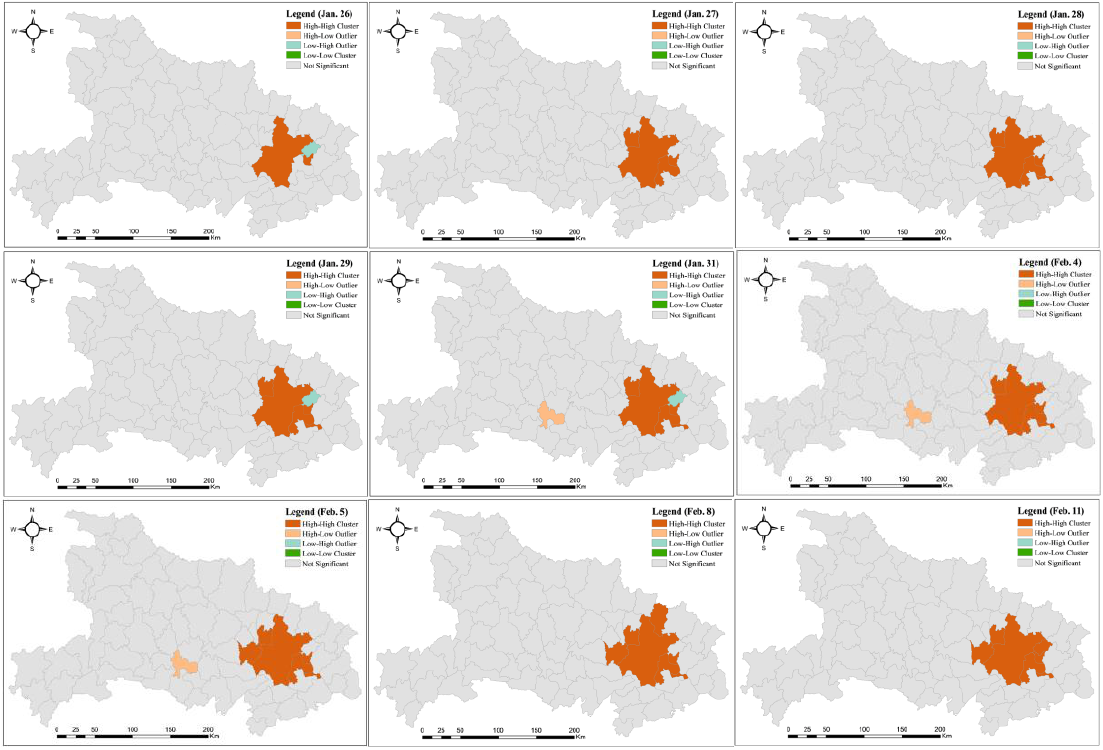
Figure 5. The dynamic process of the spatial patterns of the incidence rate .